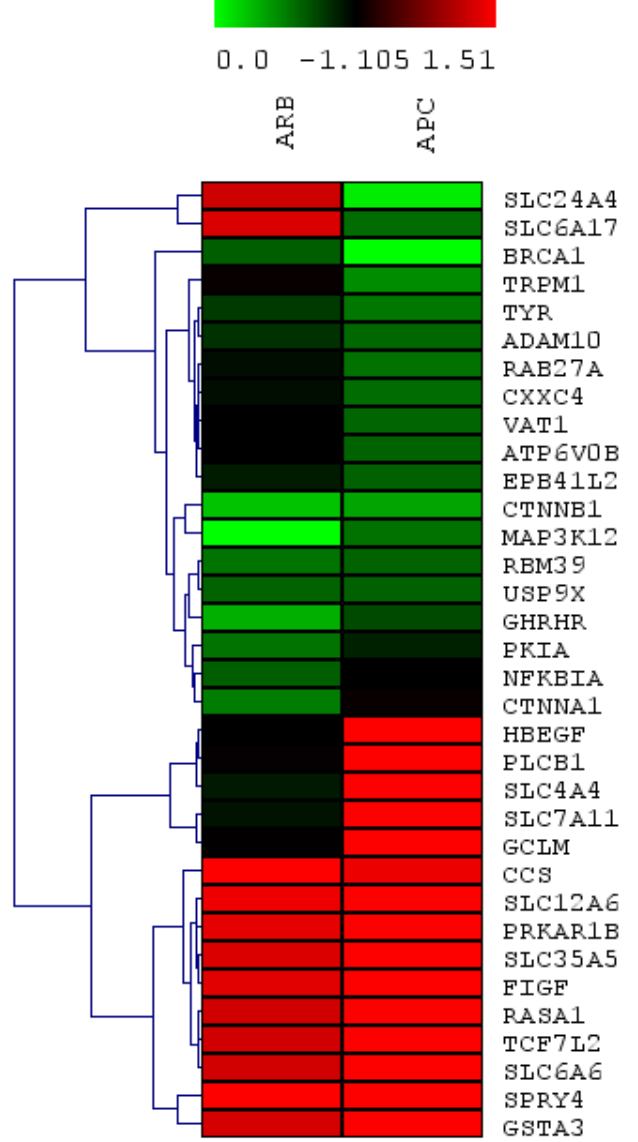
Figure 1. Heat map and hierarchical clustering of 34 genes in response to treatment with argan press-cake (APC) or by arbutin (ARB) in B16 melanoma cells. Clustering was calculated using Euclidian distance in the TIGR’s MultiExperiment Viewer v4.9.0 software. Rows and columns represent genes and experimental samples, respectively. Gene expression ratios are presented in the heat map with green and red color indicating down and up-regulation, respectively.